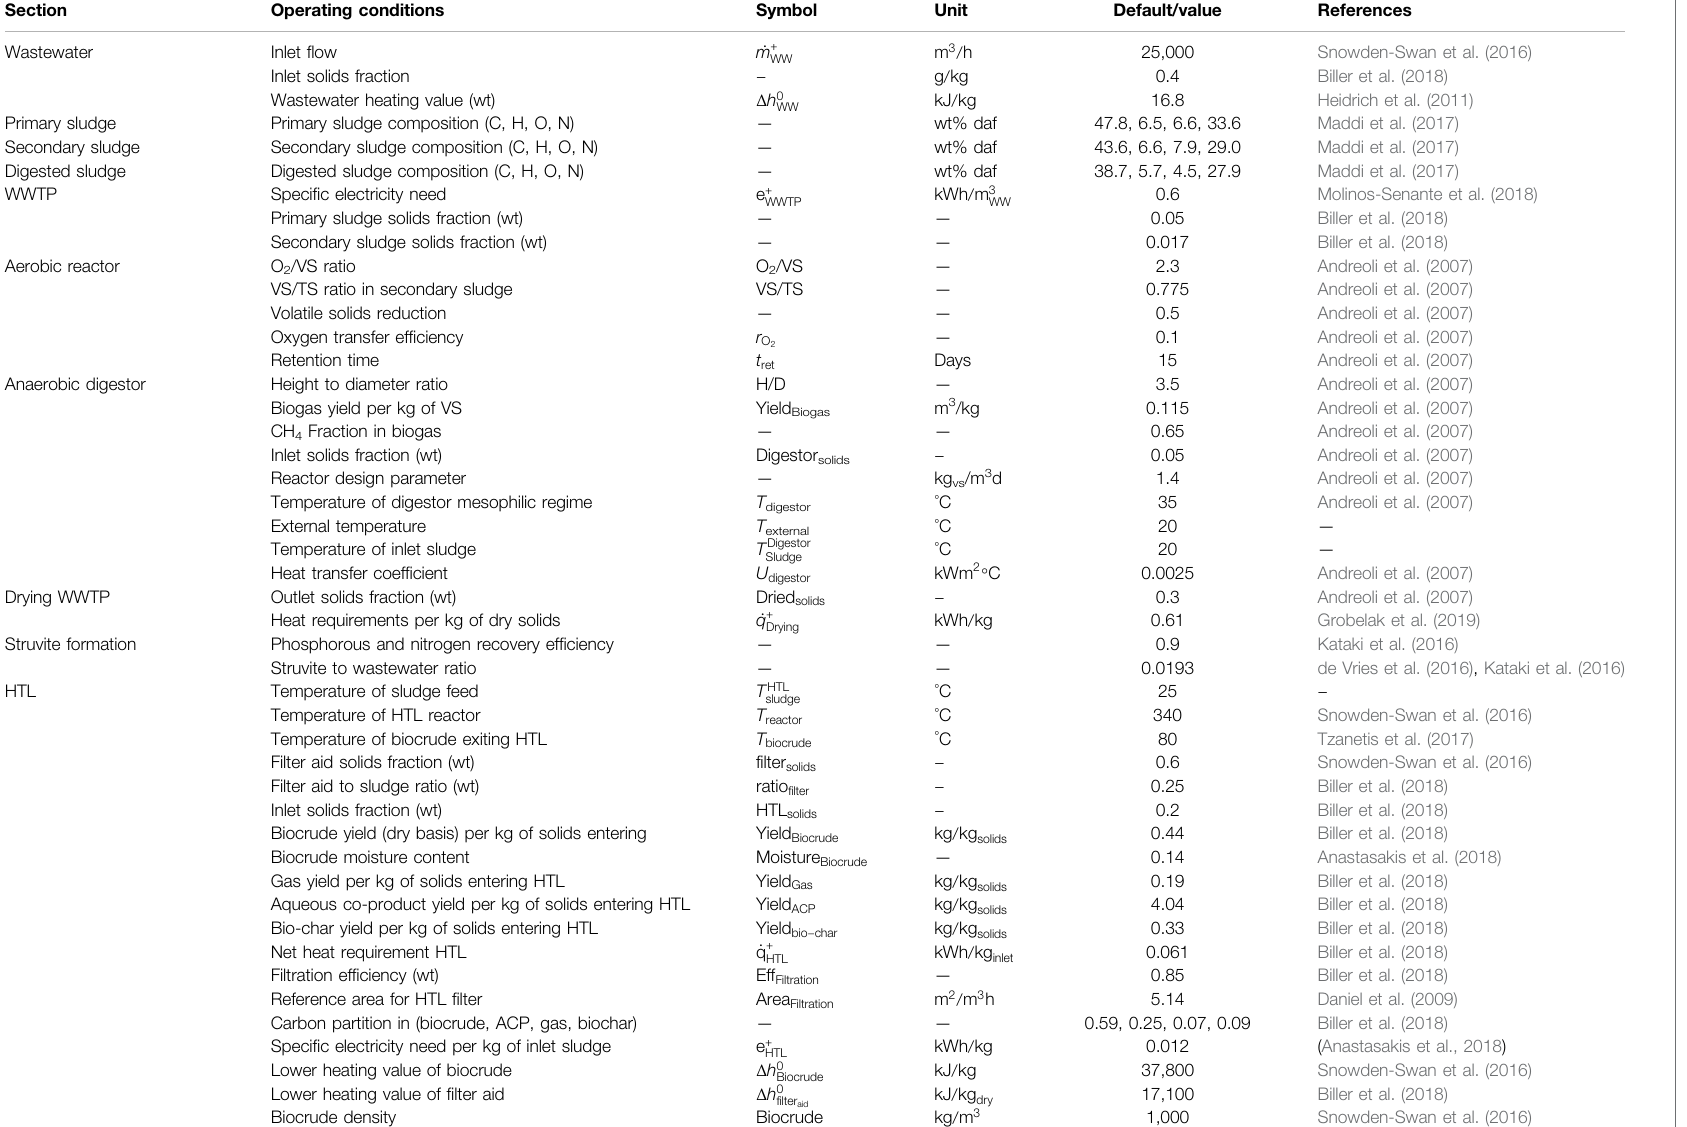
TABLE 4 | General assumptions and operating